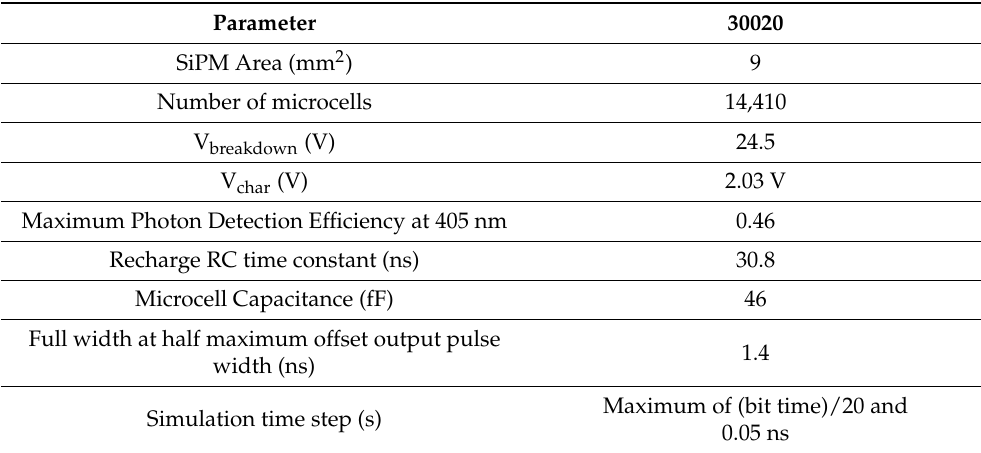
Figure 5. The measured current needed to sustain a bias on the SiPM at different irradiances of 405 nm light divided by the product of the over-voltage and the PDE corresponding to the over-voltage. Table 2. Simulation Parameters for a J-Series 30020 SiPM.